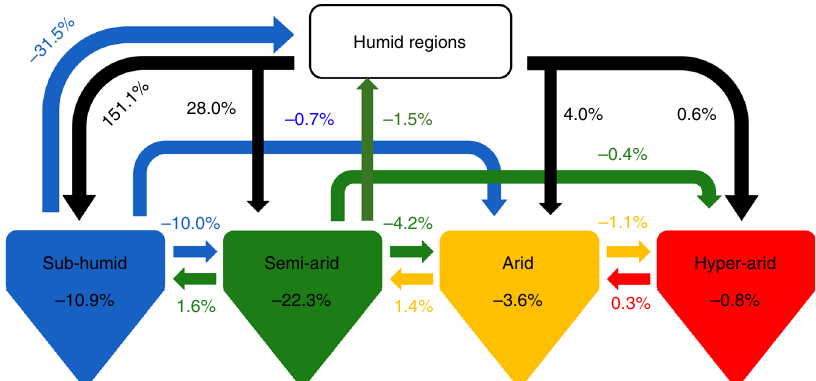
Fig. 7 Changes in dryland GPP due to expansion and conversions. It is estimated from our study that the global dryland gross primary production (GPP) will increase by 12% in 2085 – 2100 relative to the 2000 – 2014 baseline under RCP4.5. Taking 12% as 100 units, the magnitudes in the diagram thus denote the percentage of the contribution caused by each process to this 12% change. The sum of all the numbers in the diagram is equal to 100%. Positive values indicate the increased GPP for the corresponding dryland subtypes and negative values indicate the decreased GPP for the corresponding dryland subtypes. For example, − 31.5% means a reduction in the GPP contribution to the 12% change for the subhumid subtype due to its conversion to humid lands, 151.1% means an increase in the GPP contribution to the 12% change for the subhumid subtype due to its conversion of humid lands to the subhumid subtype, and − 10.9% means a reduction in the GPP contribution to the 12% change for the subhumid subtype due to its degradation within its subtype. Note that changes in GPP in humid regions are not the focus in this